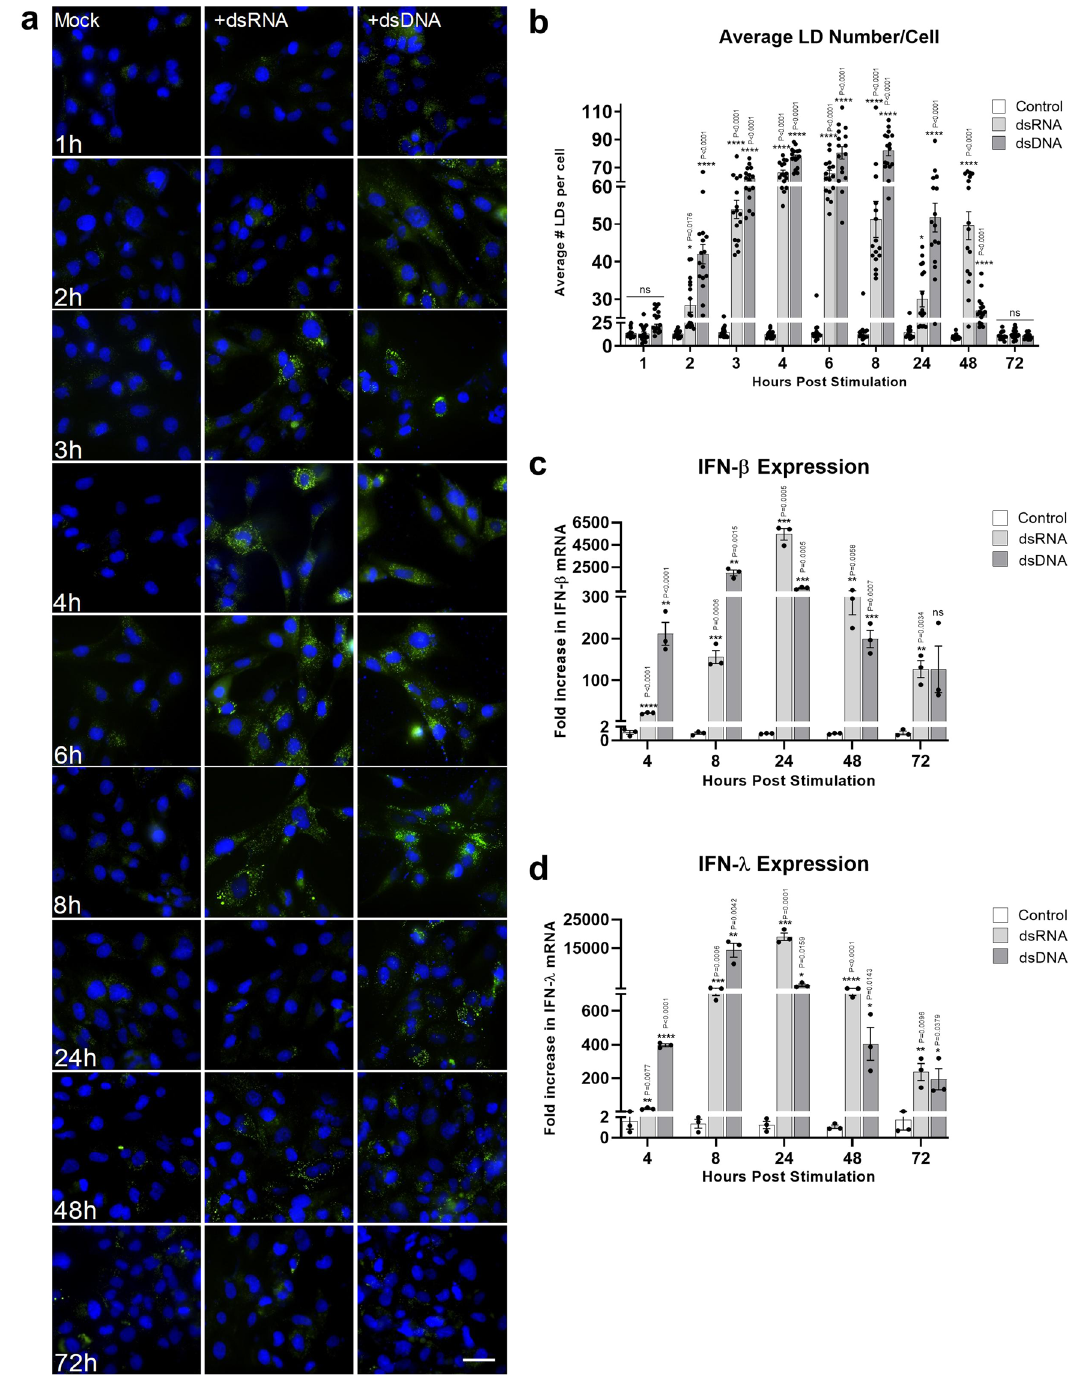
Fig. 3 Lipid Droplet accumulation is transient following detection of intracellular nucleic acids. a Primary immortalised astrocyte cells were stimulated with dsRNA and dsDNA and were fi xed at regular time points until 72 h post-stimulation. Cells were stained with Bodipy (493/503) to visualise LDs (green) and DAPI to visualise the cell nuclei (blue). Scale bar, 50 μ m. Images are a representation of n = 3 independent experiments. b Average number of LDs per cell were analysed from all time points using ImageJ analysis software ( n > 300 cells; n = 3 separate biological replicates). c , d Primary immortalised astrocyte cells were stimulated with dsRNA and dsDNA and RTq-PCR was utilised to quantify IFN- β and IFN- λ mRNA up to 72 h post- stimulation. In ( b – d ) error bars, mean values ± SEM, P values were determined by unpaired two-tailed Student ’ s t test with a Holm-Sidak correction for multiple comparisons (greater than 300 cells; n = 3 biological replicates). Stimulated cells were statistically compared with their respective mock controls, ns = not signi fi cant. Source data are provided as a Source Data fi